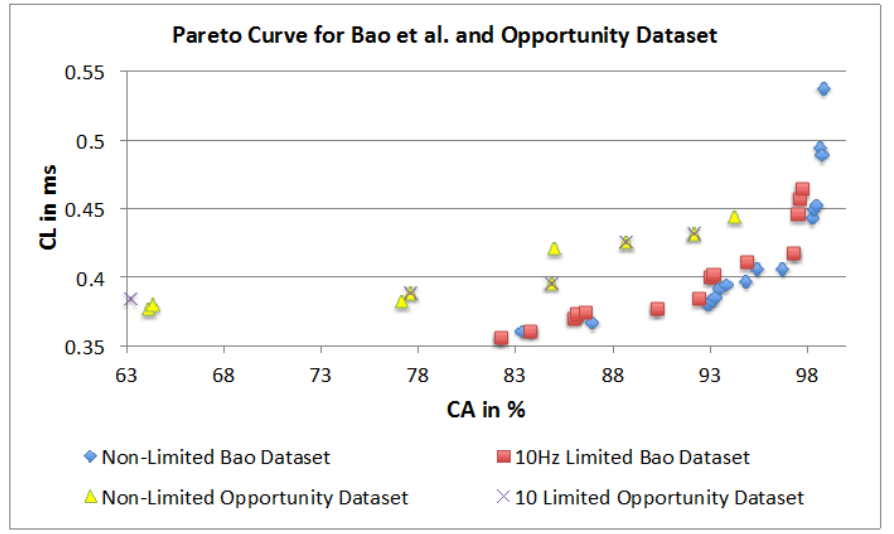
Figure 24. Dominant points on the Pareto curve for both